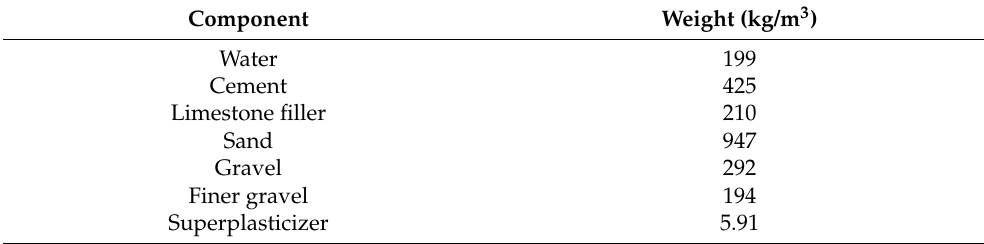
Table 1. Plain concrete formulation.